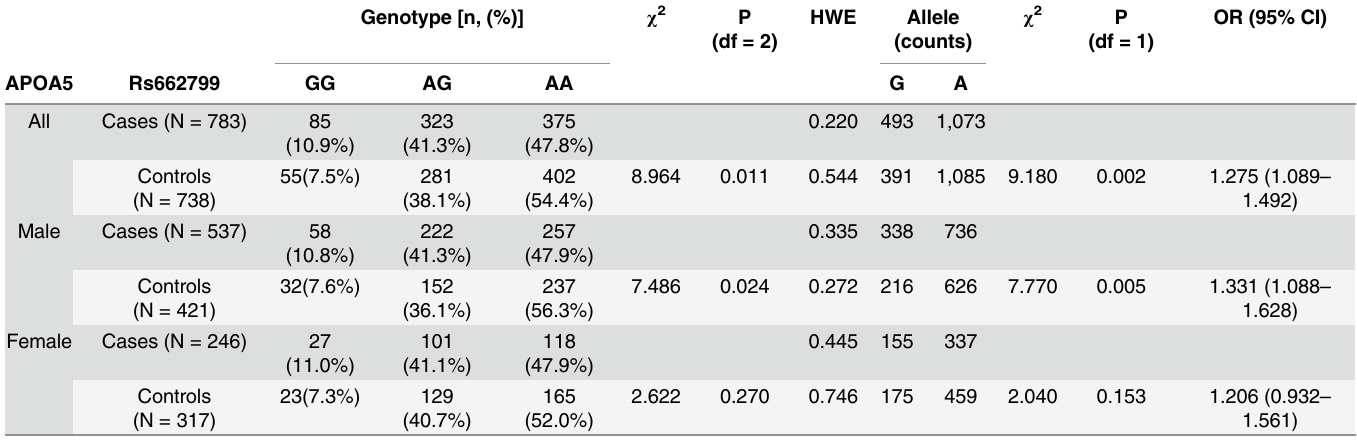
Table 1. Genotype and allele frequencies in cases and